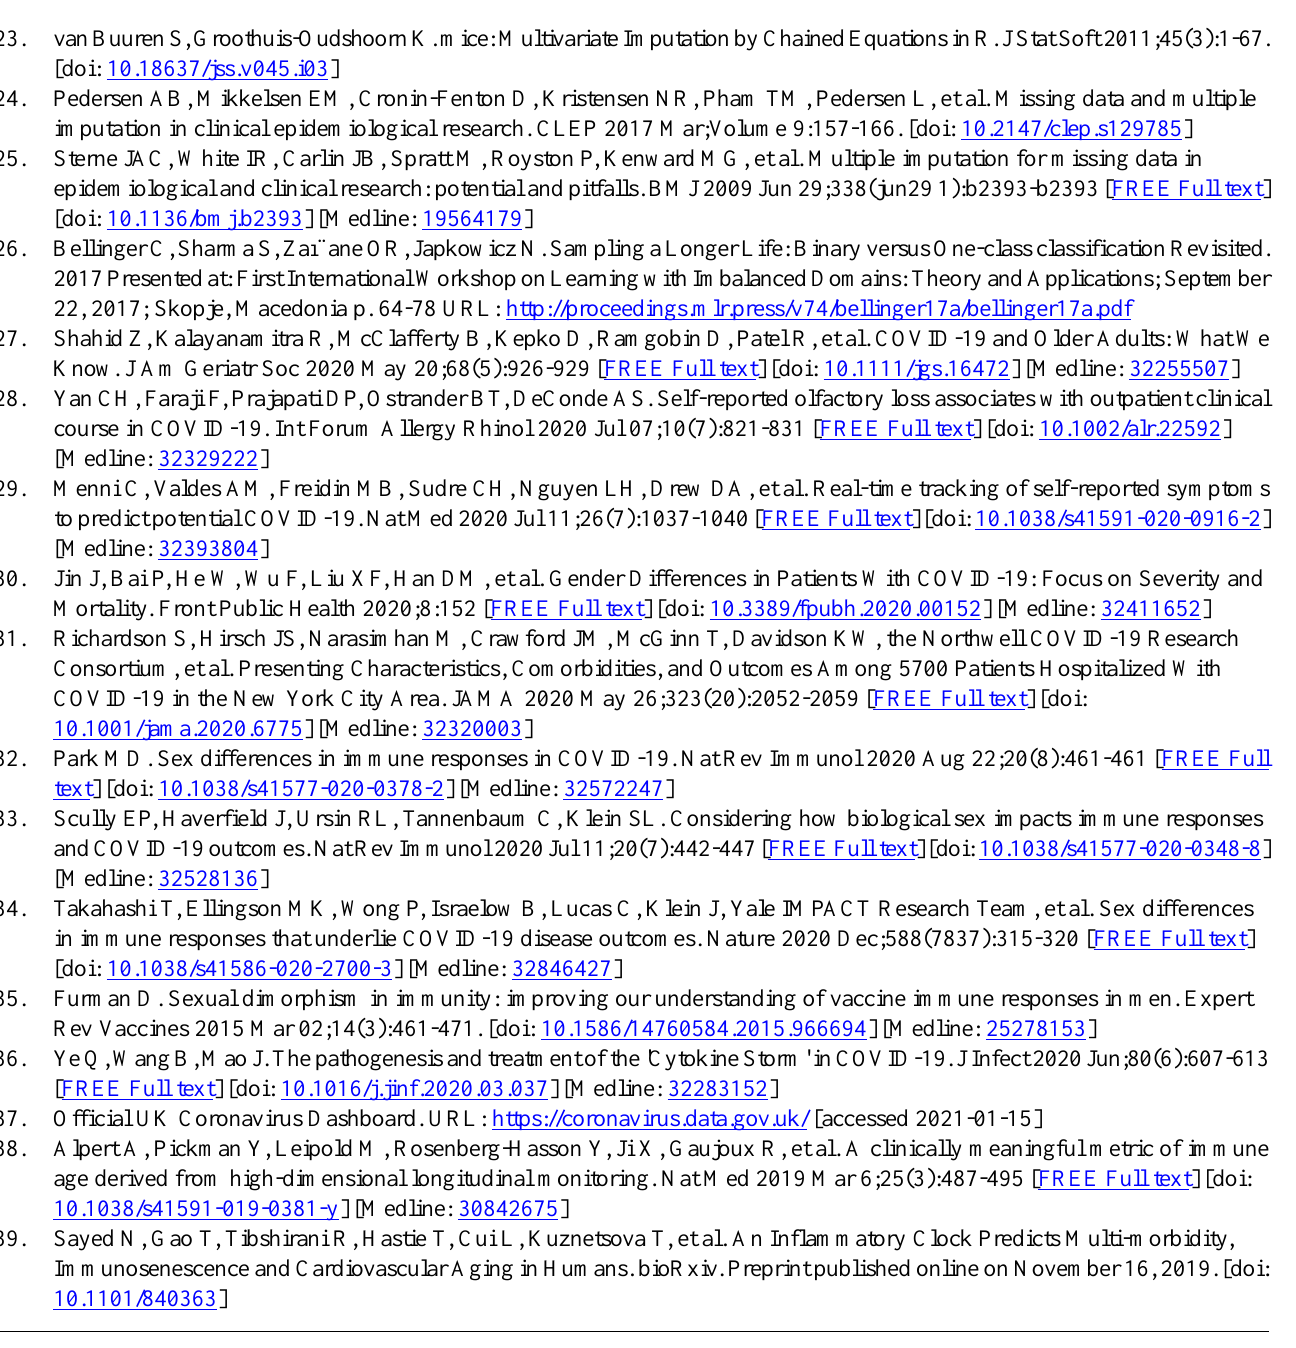
AUC: area under the curve AUROC: area under the receiver operating characteristic curve cvAUC: cross-validated area under the receiver operating characteristic curve ICU: intensive care unit WHO: World Health